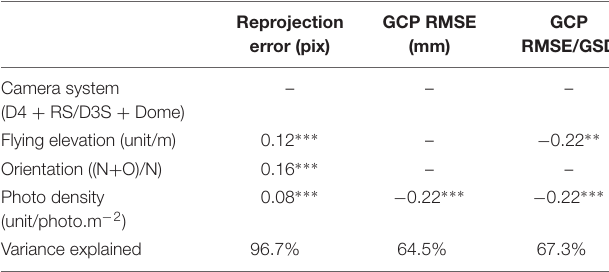
TABLE 3 | Effects of the acquisition parameters on the bundle adjustment